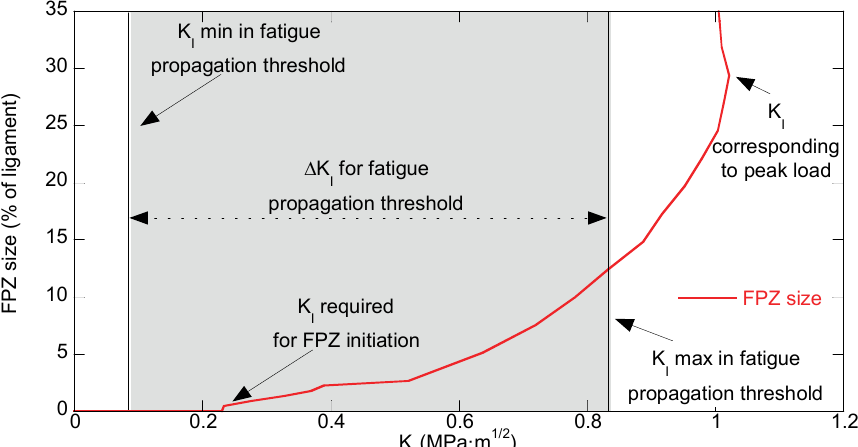
Figure 6: Fracture process zone (FPZ) size in terms of % of the ligament as a function of the stress intensity K I applied. The figure also shows the  K I corresponding to the fatigue crack propagation